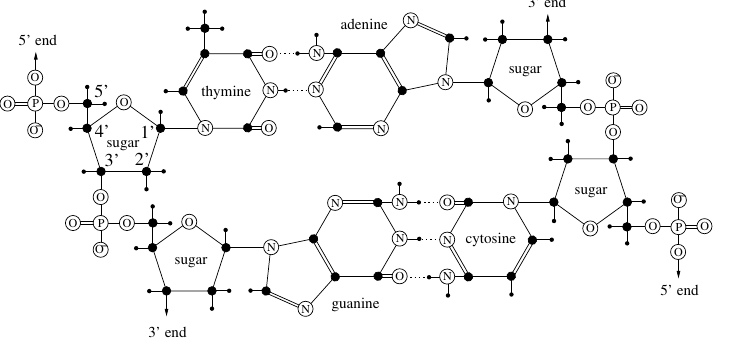
Figure 1. Schematic illustration of DNA: atoms of hydrogen are marked by small black dots, atoms of carbon by large black dots, covalent bonds are shown as solid lines, and hydrogen bonds as dotted